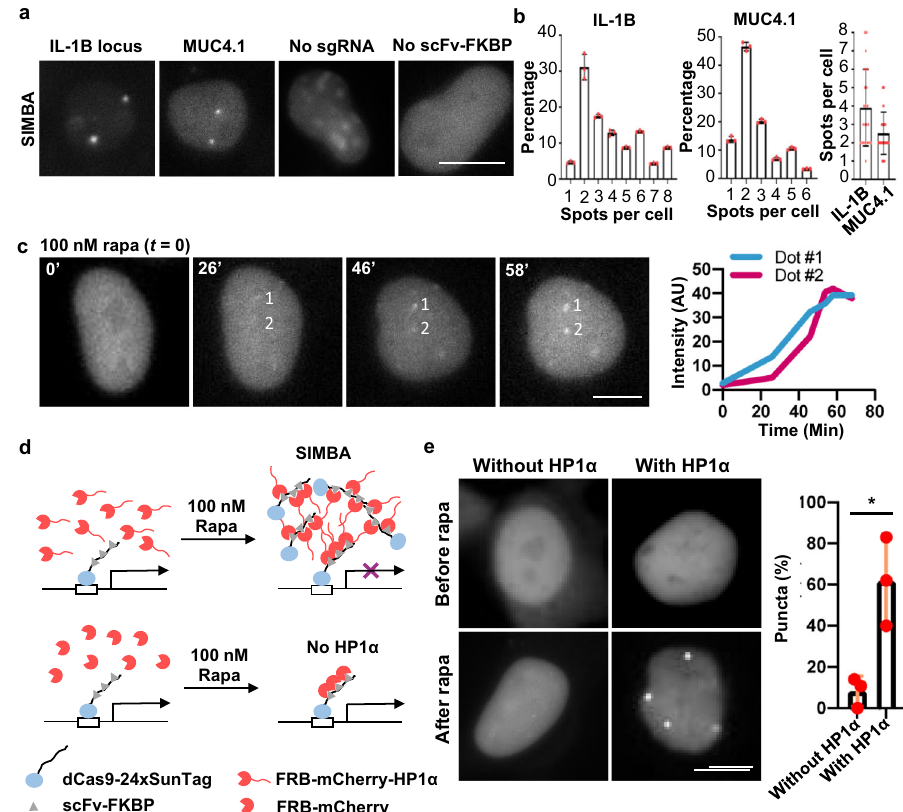
Fig.2|SIMBAcanlabelnon-repetitiveloci.a ImagesofHEK293Tcellsexpressing dCas9-24xSunTag, scFv-FKBP, FRB-mCherry-HP1 α , and a single sgRNA for the labeling of non-repetitive IL-1B or MUC4.1 locus after rapamycin treatment. Scale bar, 5 μ m. b Bar graphs show the distributions of three independent experiments (Left and Middle, n =3 biologically independent experiments) and the averages (Right) of puncta per cell detected by SIMBA labeling of IL-1B and MUC4.1 loci. n =23 cells for IL-1B group, n =29 cells for MUC4.1 group. Error bars, mean±SD. c Time-lapse images showing droplet formation at IL-1B locus following 100nM